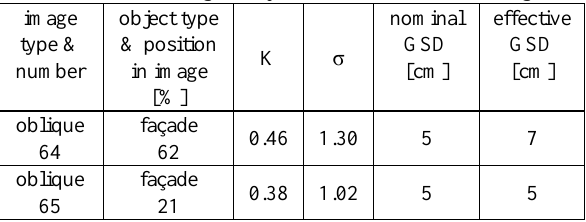
Table 2. Results of edge analysis in Canon EOS 20D